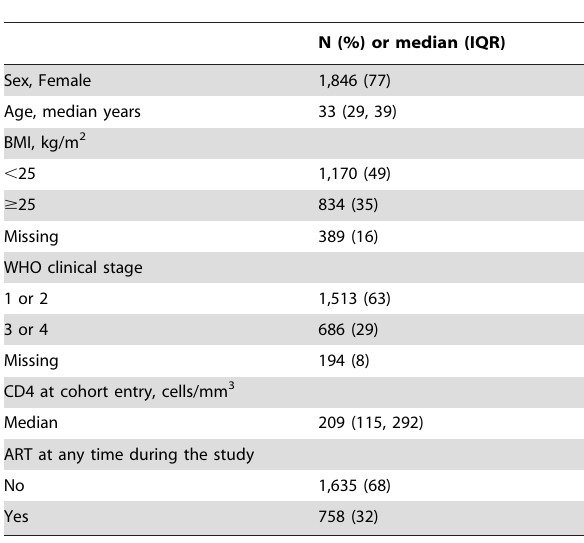
Table 1. Participant characteristics